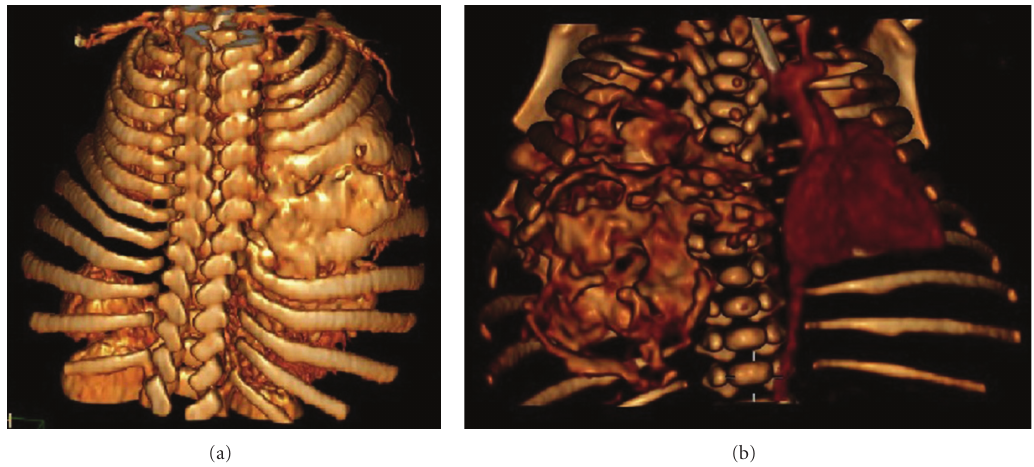
Figure 3: Posterior and anterior volume-rendered computerized axial tomography with contrast injection revealed a mass occupying the right hemithorax measuring 60 × 50 × 50 mm (the cranial-caudal, transverse, and anteroposterior diameter) in contact with the right costal wall which it appeared to depend